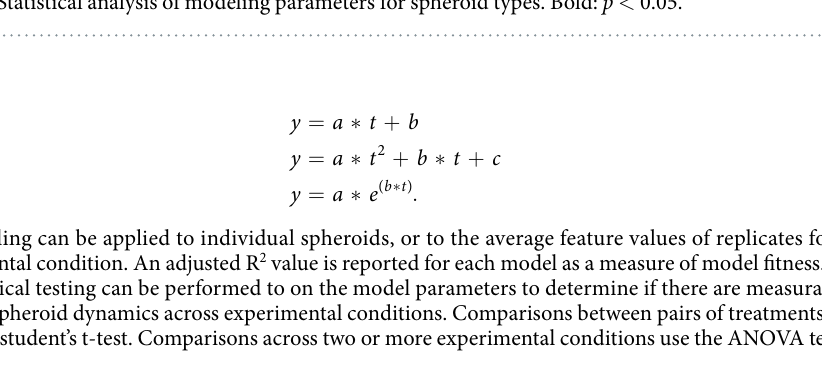
Table 2. Statistical analysis of modeling parameters for spheroid types. Bold: p <